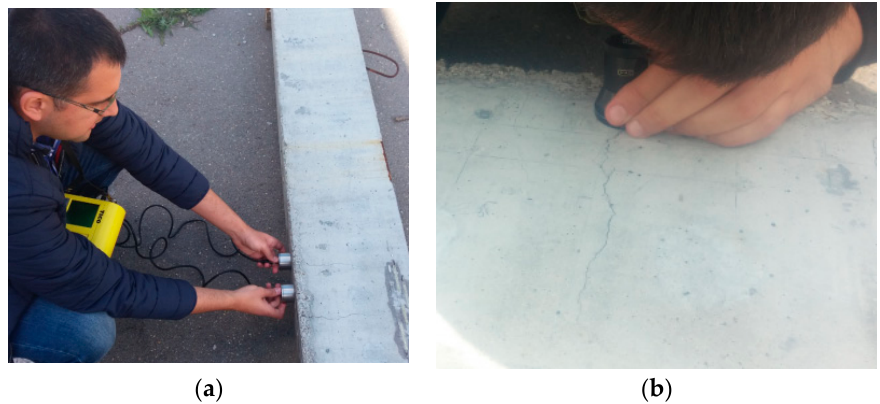
Figure 5. Determination of crack depths in reinforced concrete elements by ultrasonic testing instrument Proceq-TICO ( a ), visually by using crack magnifier Proceq ( b ) (personal archive).